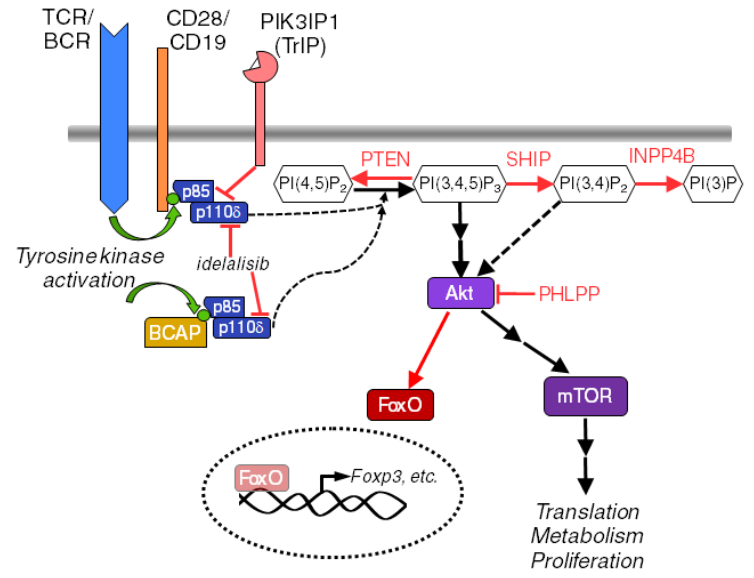
Figure 1. Major regulators and effectors of the phosphatidylinositol 3-kinase (PI3K) pathway in lymphocytes. Molecules and interactions discussed in the text are highlighted here. Activating events are indicated with black arrows. Inhibitory events are depicted with red lines or arrows. This is not an exhaustive model of the pathway. BCAP, B-cell adapter for PI3K; BCR, B cell receptor; INPP4B, inositol polyphosphate-4-phosphatase type II B; mTOR, mammalian target of rapamycin; PHLPP, PH domain and leucine-rich repeat protein phosphatase; PIK3IP1, PI3K interacting protein 1; PTEN, phosphatase and tensin homolog deleted on chromosome 10; SHIP, src homology 2 containing 5’-inositol phosphatase; TCR, T cell